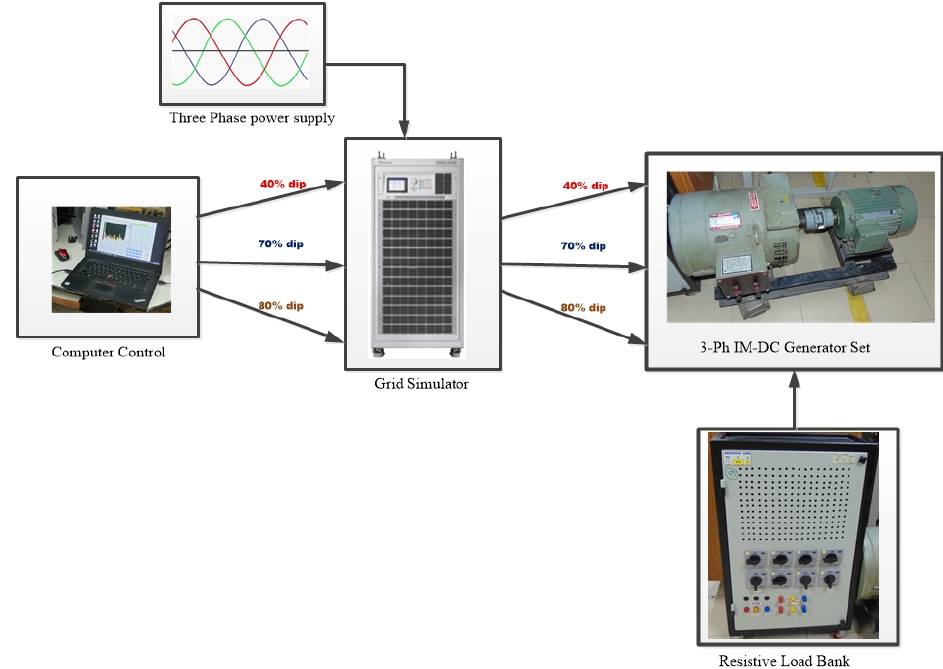
Figure 11. Voltage sag conditions in grid connected to induction motor under loaded conditions.